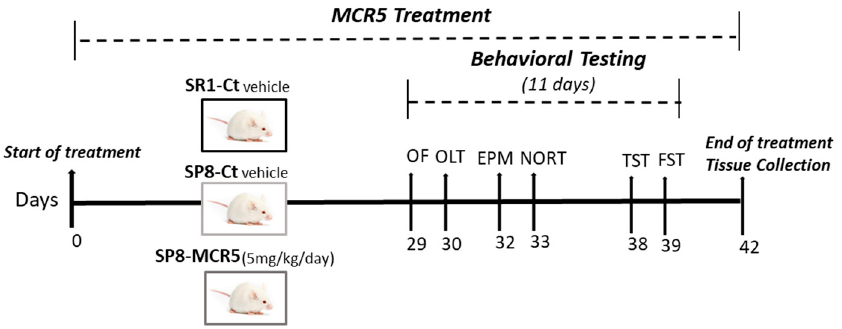
Figure 1. Scheme of experimental design.